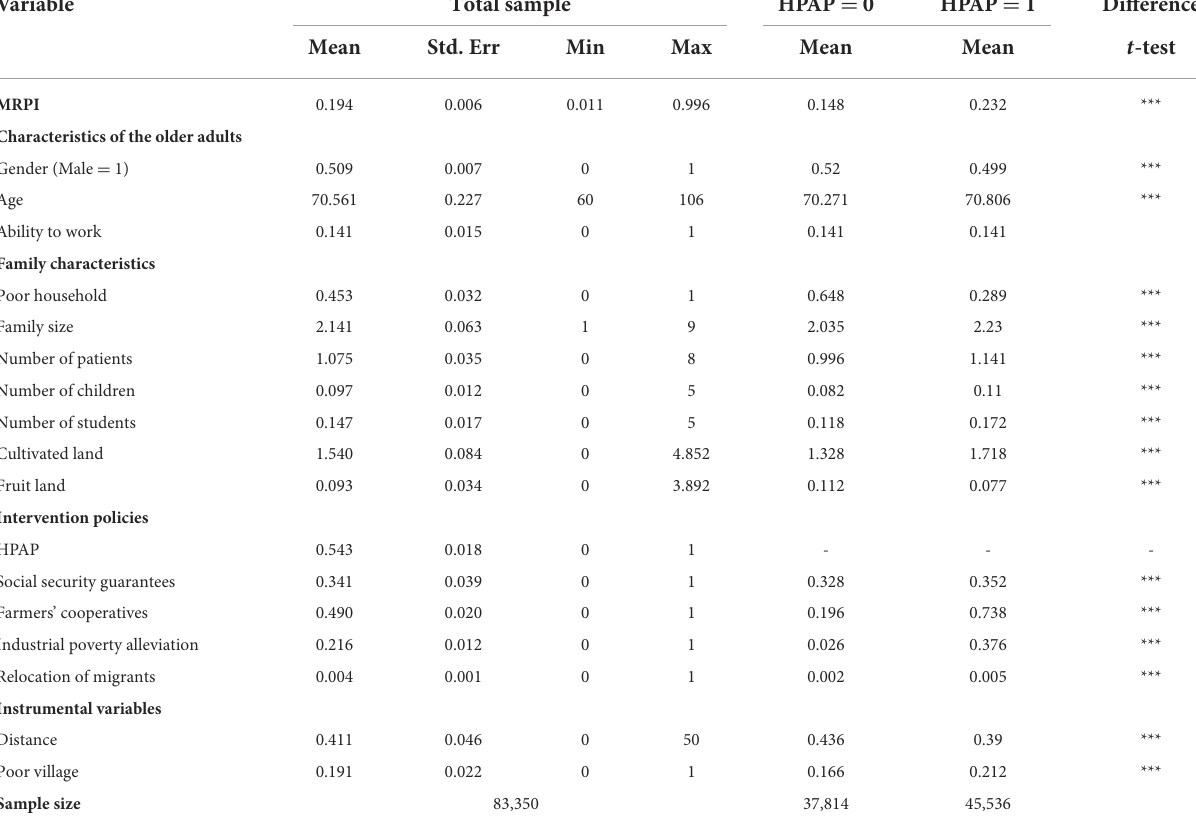
TABLE 4 Descriptive statistics for selected variables,